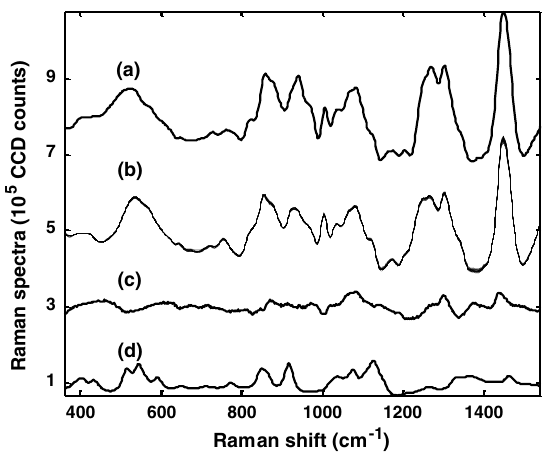
Fig. 1. (a) Typical Raman spectrum of skin with background removed; (b) typical simulated Raman spectra, 25 sample spectra are overlaid; (c) di®erence between the ¯rst two spectra in (b), magni¯ed 10 (cid:4) ; (d) glucose Raman spectrum, 90 mg/dL, magni¯ed 100 (cid:4) . The spectra are displaced vertically for better visualization.